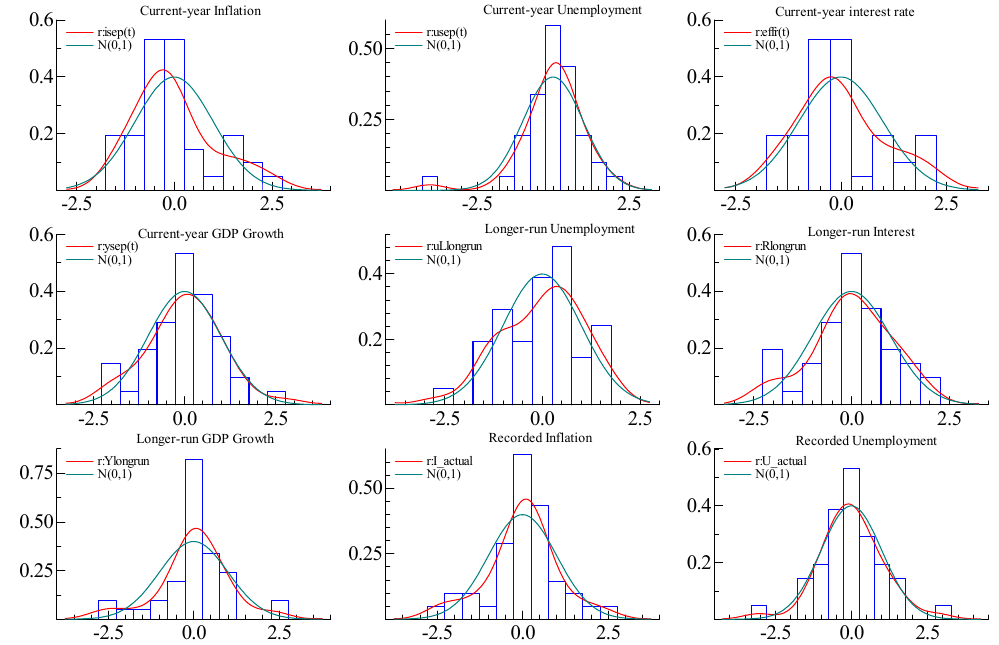
Figure A5. Empirical distribution of residuals—histograms, density, and density of N(0,1). When taken together, the results suggest that the residuals are consistent with the maintained assumptions for parameter estimation.